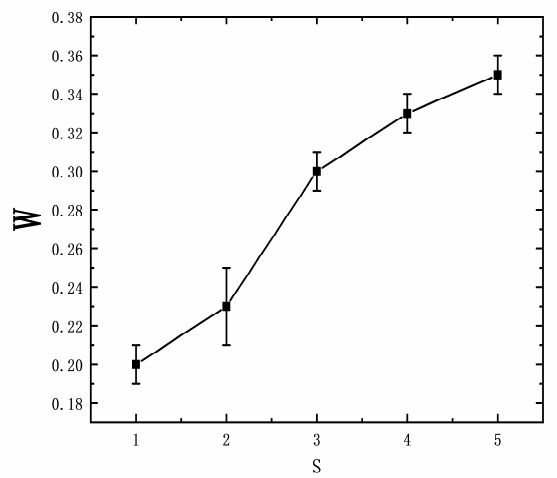
Figure 4. The transmission probability W versus S.